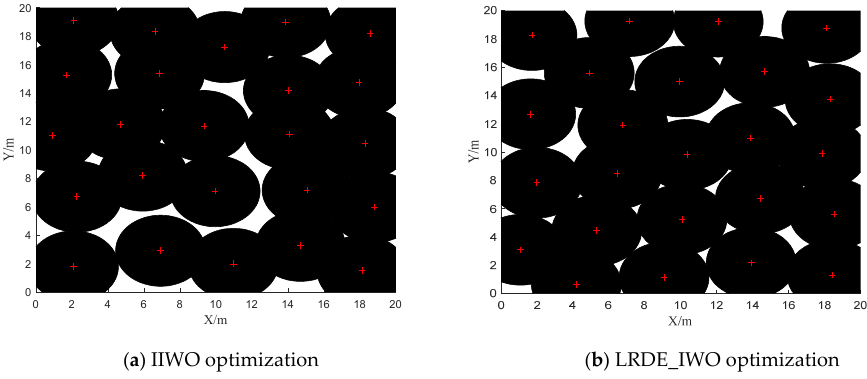
Figure 10. Coverage optimization iterative curve of IIWO and LRDE_IWO.